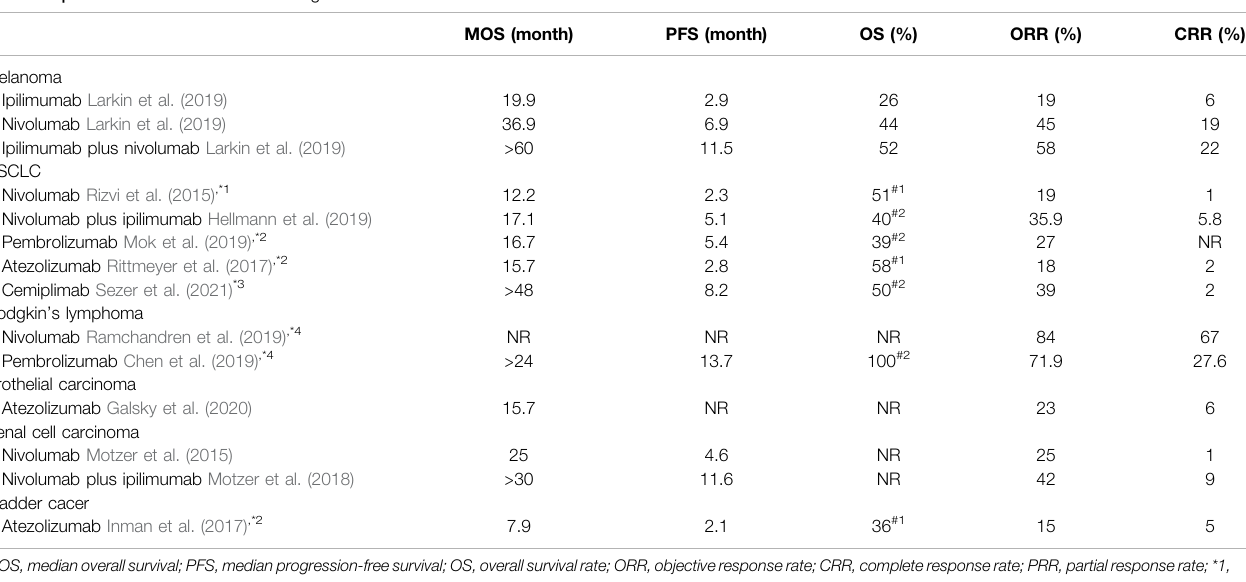
TABLE 1 | The clinic data of ICIs for treating cancers.